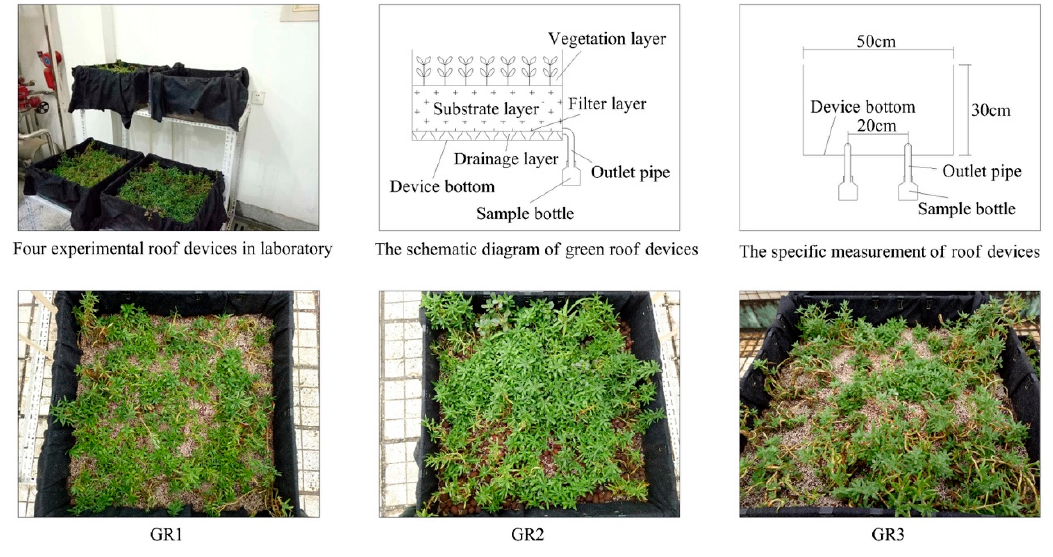
Figure 1. Extensive green roof (GR) experimental devices.